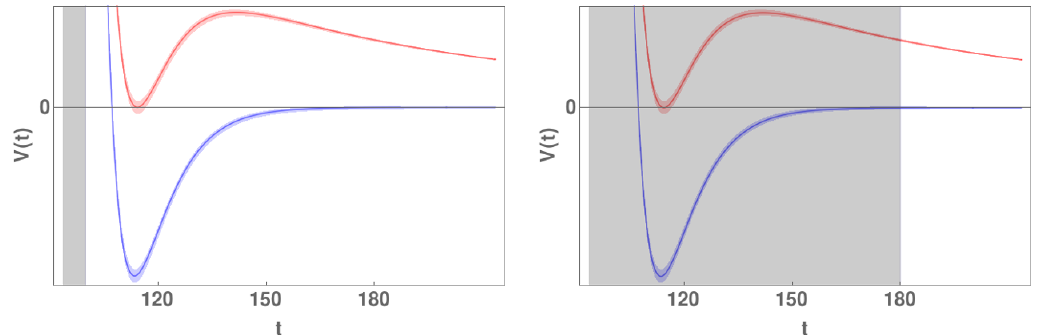
Figure 2 . We plot the KKLT uplift as in (cid:12)gure 1, but with a shaded area that marks the region Re( T ) < N D 3 where the 10 d geometrical setup is beyond control. Left: if (say) N D 3 = 100 can be realized simultaneously with the parameter choices of (cid:12)gure 1 the uplifted vacuum lies in a controlled region and the uplift can be trusted. Right: if N D 3 (cid:29) 100 is required, the vacuum region cannot be trusted. We (cid:12)nd that the scenario on the left is hard or impossible to realize, while generically we are forced into the scenario displayed on the